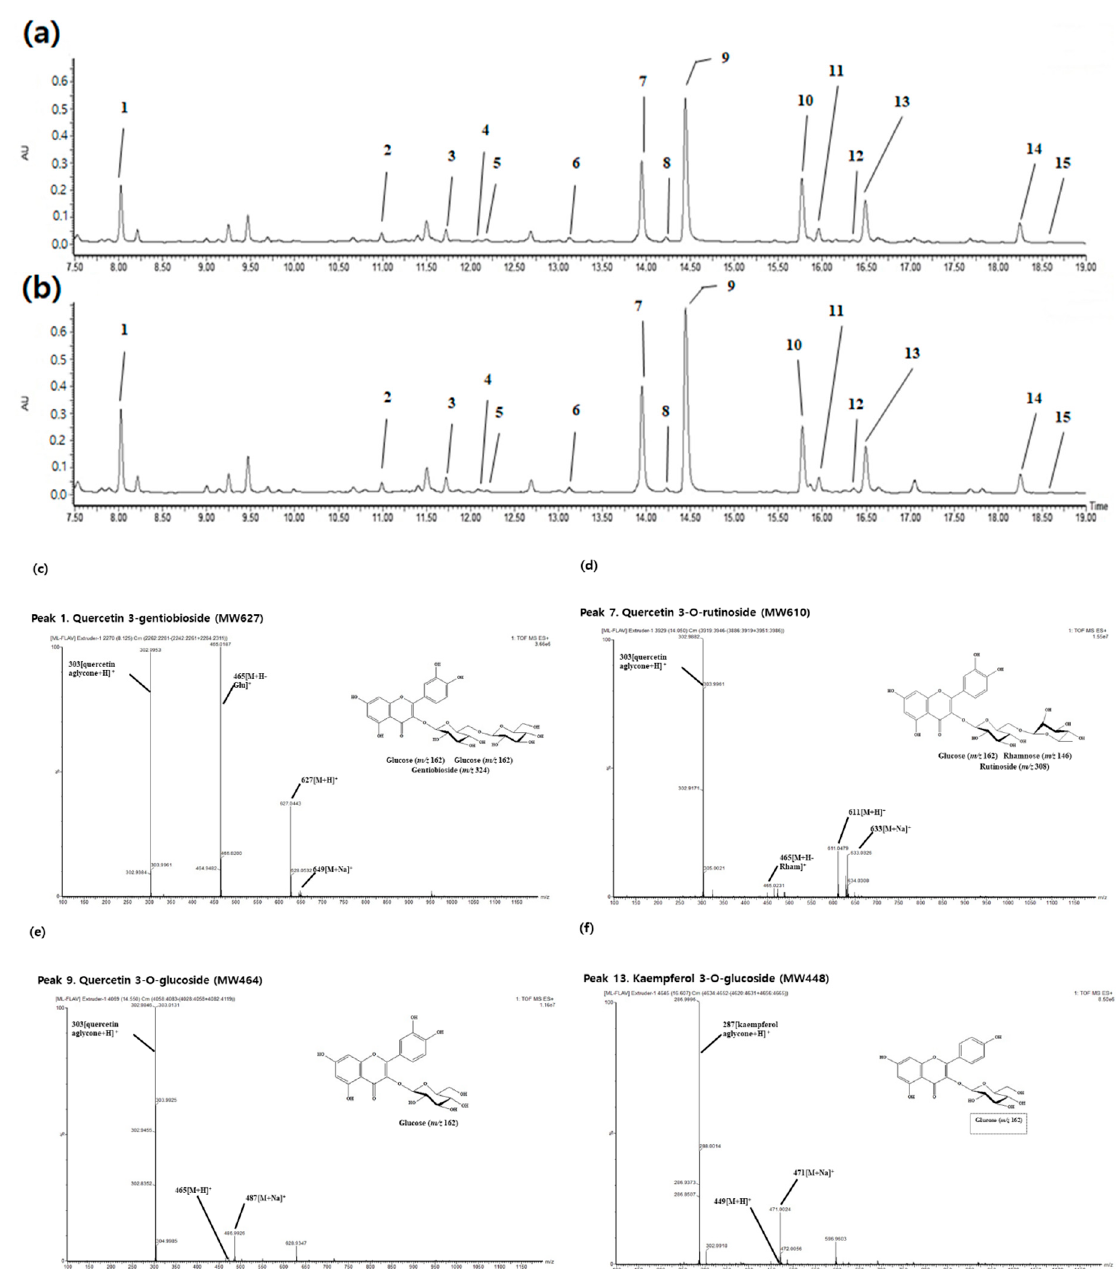
Figure 2. Liquid chromatograms of flavonoids in ( a ) raw mulberry leaves and ( b ) the optimal extruded mulberry leaves (114 °C, 20%, 232 rpm). ( c – f ) Mass spectrum of major flavonoids. ( c ) Quercetin 3 ‐ gentiobioside, ( d ) Quercetin 3 ‐ O ‐ rutinoside, ( e ) Quercetin 3 ‐ O ‐ glucoside, and ( f )